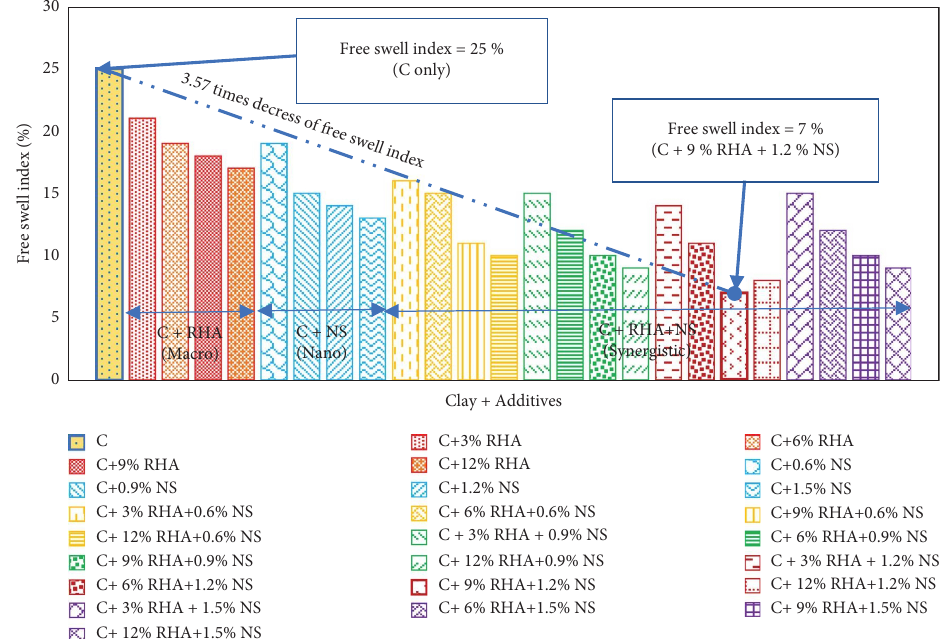
Figure 4: Free swell of clay and blends of clay plus RHA and NS synergistic.